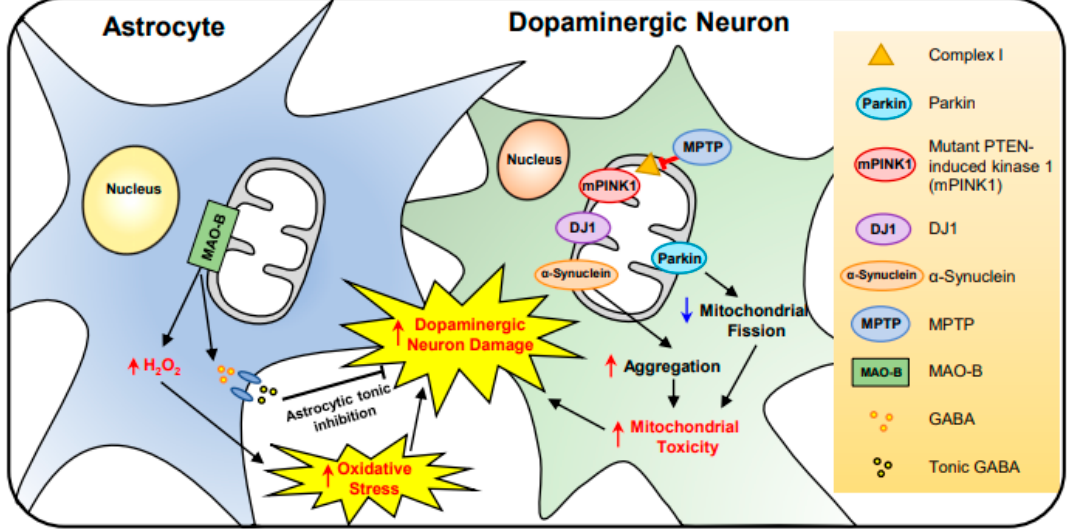
Figure 4. The effect of mitochondrial dysfunction on astrocytes and neurons in Parkinson’s disease (PD). In the dopaminergic neuron, 1-methyl-4-phenyl-1,2,3,6-tetrahydropyridine (MPTP) causes a parkinsonian syndrome characterized by a loss of dopamine-producing neurons. Autosomal recessive mutations in Parkin, Phosphatase and tensin homolog (PTEN)-induced kinase 1 (PINK1), and DJ-1 increases mitochondrial toxicity. Thus, elevating α -Synuclein aggregation and mitochondrial degradation. On the other hand, in reactive astrocytes, monoamine oxidase B (MAO-B) produces GABA, which is released in a tonic manner, affecting neuronal degeneration. As a result, MAO-B activity also induces oxidative stress via H 2 O 2 that ultimately triggers the damage of dopaminergic neurons.